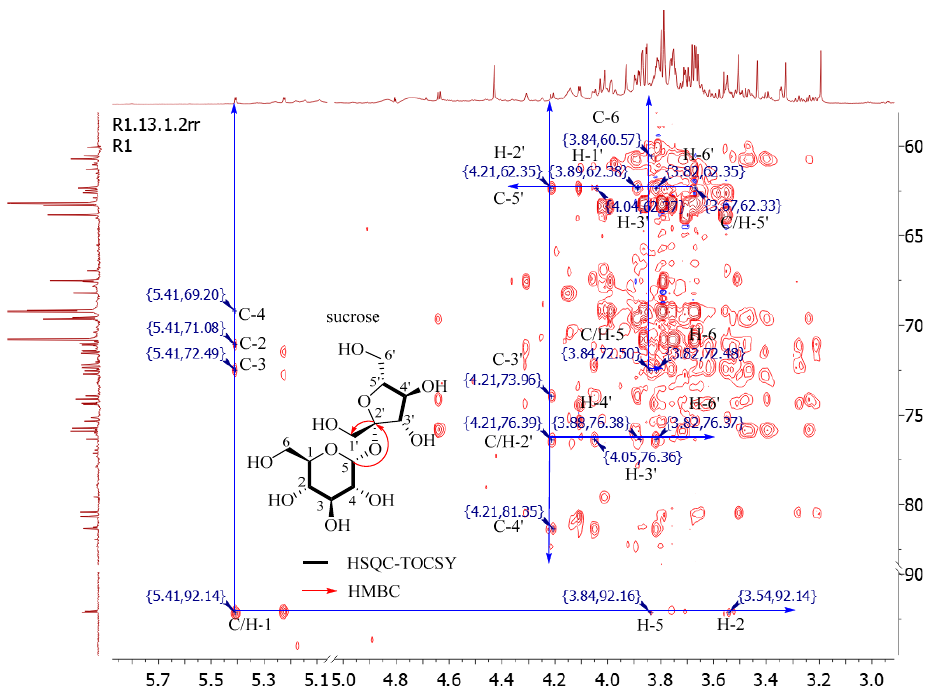
Figure 3. The HSQC-TOCSY correlations of sucrose from CS aqueous extract. The structural determination of the fructose fraction of sucrose began with the HMBC association between δ H 5.41 (H-1) and δ C 103.6 (C-1 ′ ). δ H 3.67 had HMBC-related signals with δ C 103.6, which was determined as C-5 ′ in combination with the HSQC signal ( δ C 62.3). In the HSQC-TOCSY spectrum, starting from C-5 ′ , along the direction of the hydrogen spectrum, there were δ H 3.82, 3.88, 4.05, 4.21 from the high field to the low field. Four groups of signals, δ 3.82 → 60.1 (C-6 ′ ), δ 3.88 → 81.3 (C-4 ′ ), δ 4.05 → 74.0 (C-3 ′ ), δ 4.21 → 76.4 (C-2 ′ ), were obtained by combining the HSQC spectra and the connection sequence δ H 4.21 (H-2 ′ ) → 4.05 (H-3 ′ ) → 3.88 (H-4 ′ ) was determined by 1 H- 1 H COSY. Finally, the above signals were confirmed to be in the same coupling system by the relevant signals in the HSQC-TOCSY spectrum of C/H-2 ′ . Based on the above analysis, it was determined that sucrose was contained in the CS. The main HSQC-TOCSY-related signals of other saccharide components are shown in Figure S11. The signal assignment processes for other compounds by the 1D and 2D NMR spectra were the same as those for sucrose.